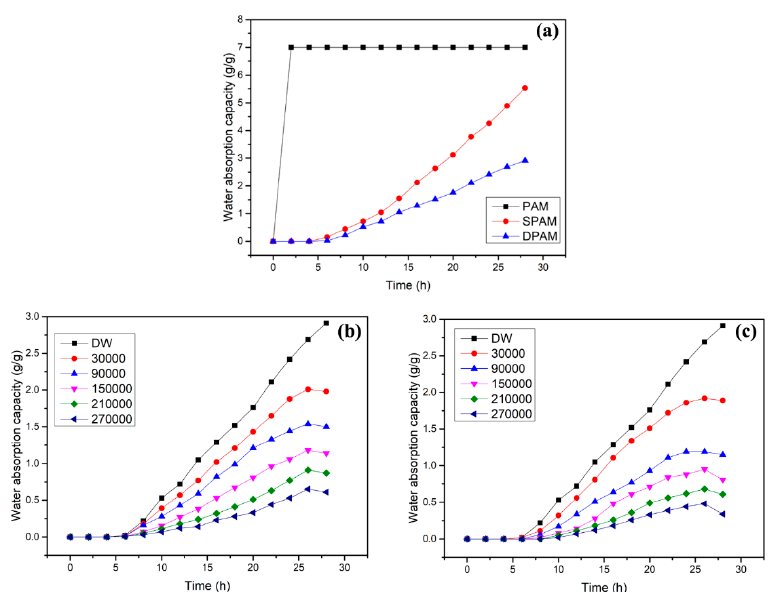
Figure 11. Water-absorption capacity of ( a ) synthesized polymers in distilled water ( b ) DPAM in KCl solution ( c ) DPAM in NaCl solution.